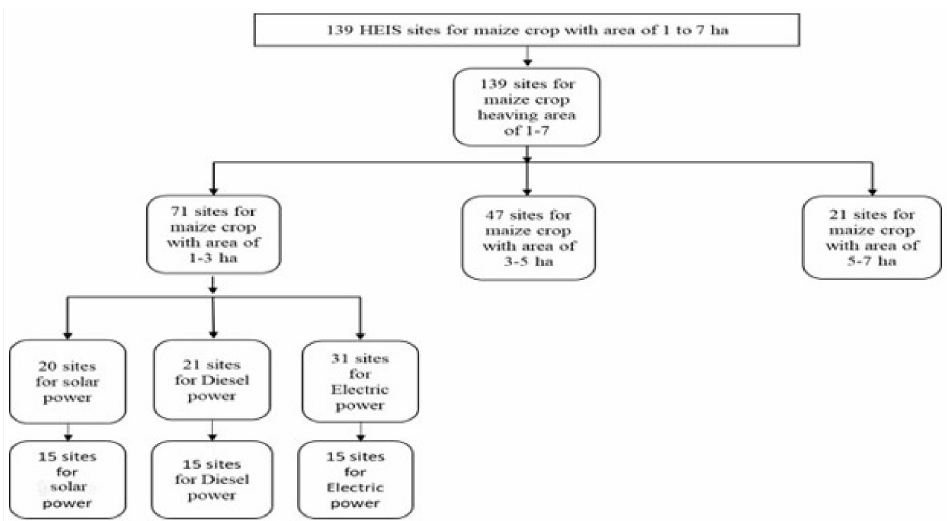
Figure 2. Selection of HEIS site